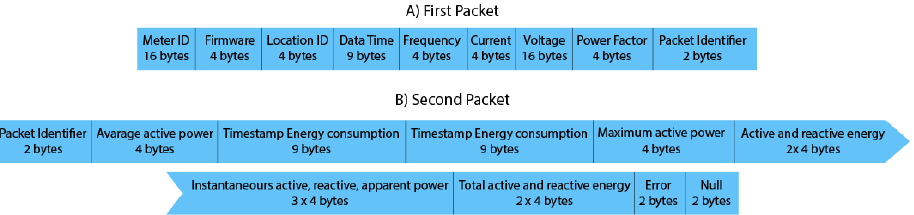
Figure 5. Packages of the SMs with size of 31 bytes.